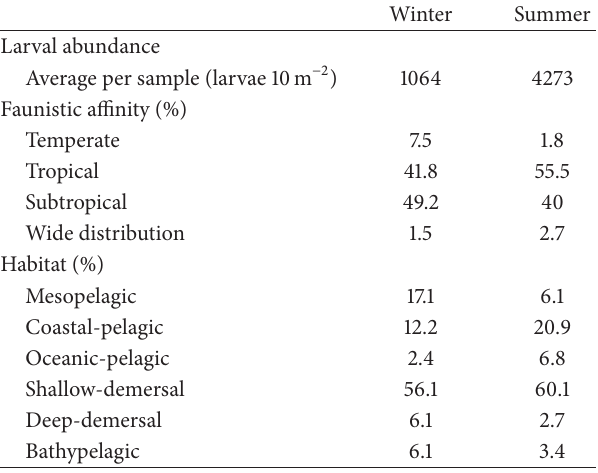
Table1:Larvalabundancebyfaunisticaffinityandhabitatregistered in the Gulf of California, Mexico (winter and summer of 2005 and 2007). Values are given as the average of winter (January 2007